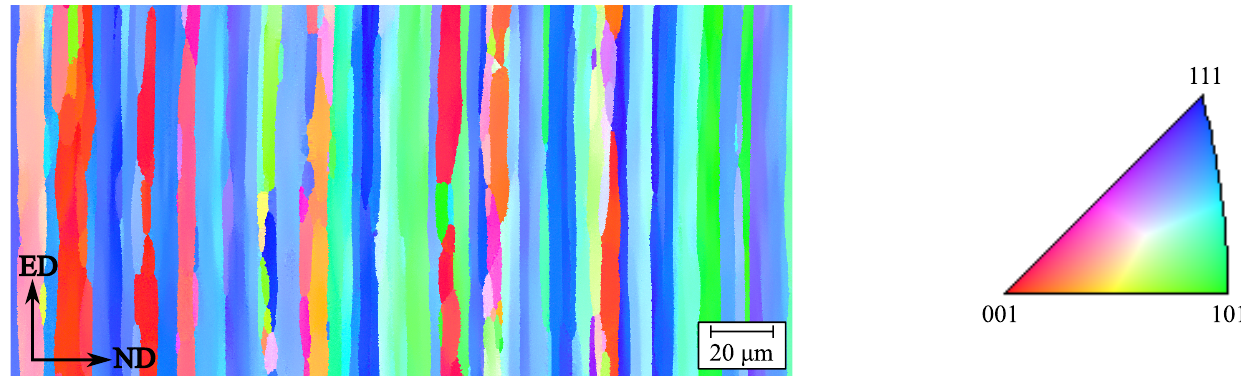
Figure 4. Grain orientation mapping for alloy AA6110 obtained from EBSD measurements, showing the non-recrystallized grain structure of the alloy. Please note that the cutoff value for individual grains is defined for a misorientation angle greater than 2 ◦